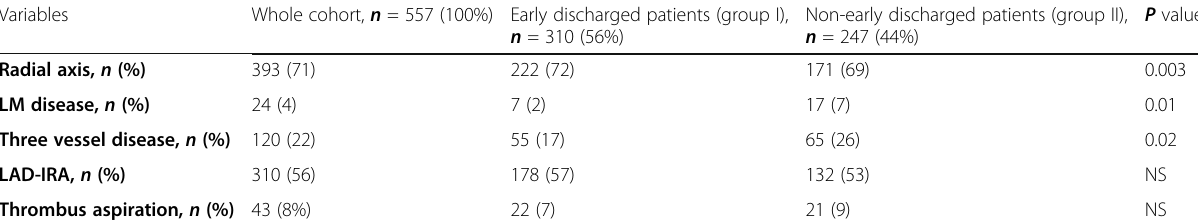
Table 3 Coronary angiography findings in the whole cohort and comparison of early discharge group versus non-early discharge group